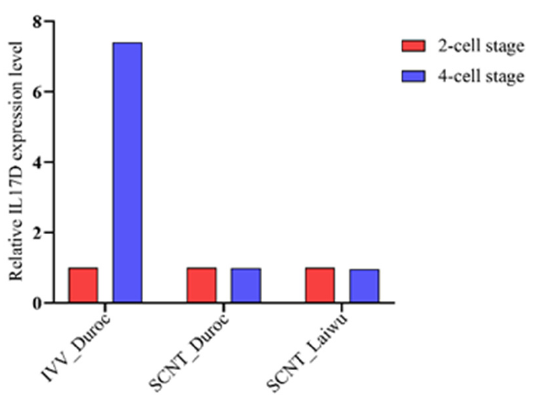
Figure 1. Relative IL17D mRNA expression level in 2-cell and 4-cell stage IVV Duroc embryos, SCNT Duroc embryos, and SCNT Laiwu embryos.